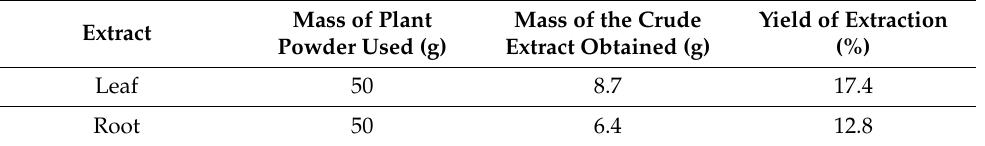
Mass of the Crude Extract Obtained (g)